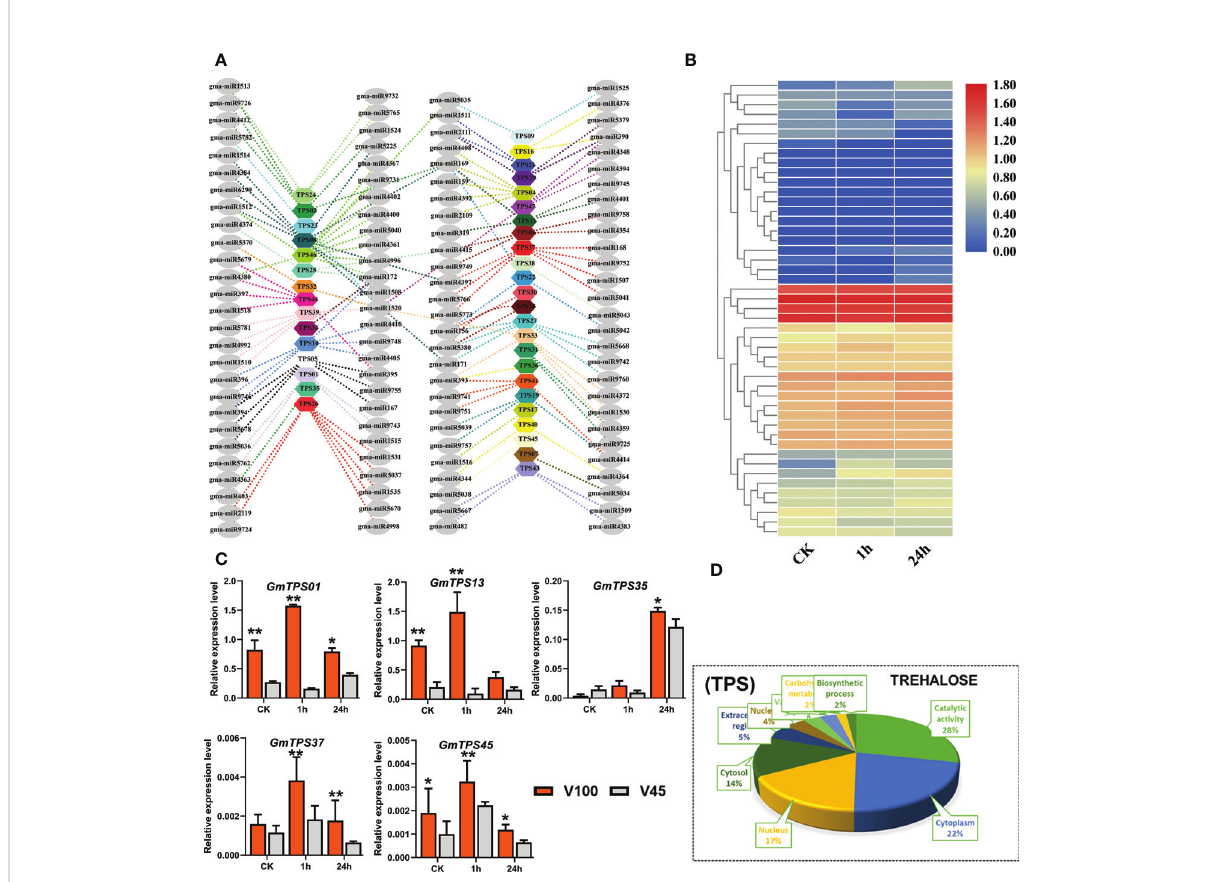
FIGURE 8 GmTPS genes and posttranscriptional regulation V100 and V45. (A) Posttranscritpional regulation of GmTPS genes by gma-miRNA. (B) RNA-seq expression analysis of GmTPS genes under (CK) and cold stress conditions. Expression data was normalized by log 2 FC. (C) qRT-PCR veri fi cation of GmTPS genes in V100 and V45. (D) Gene ontology analysis of GmTPS. Data was analyzed with the Statistix 8.1. The ** and * asterisks indicate the signi fi cant differences at p-value <0.01 and p-value <0.05,